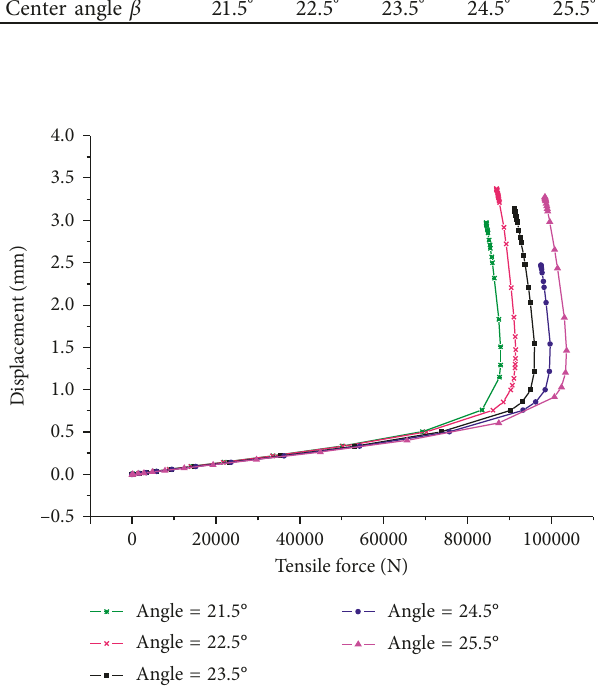
Figure 23: Tension and displacement diagram of the joint cor- responding to different center angles.